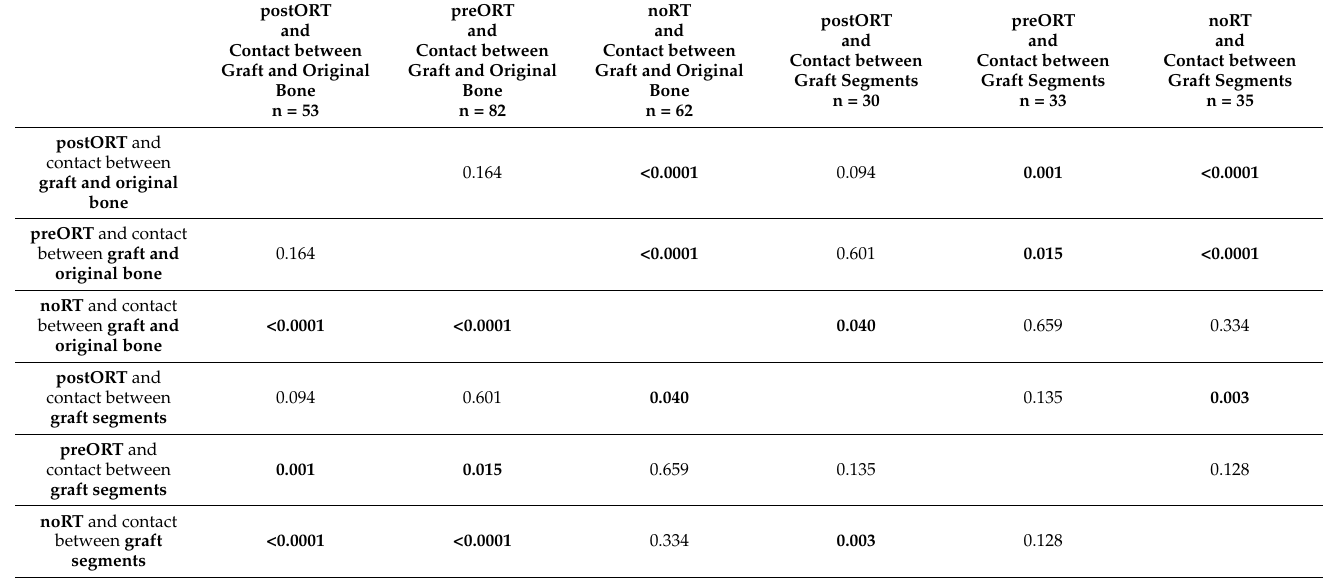
Table 2. p -values of ossification between bone graft and original bone of the jaw regarding subgroups noRT, preORT, and postORT (significant p -values are marked bold